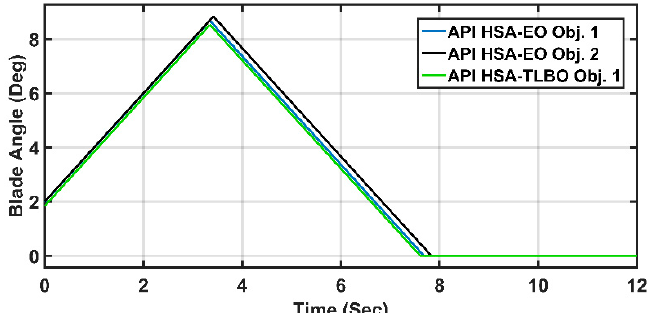
Figure 22. ( a ) Active power responses of normal fourth case. ( b ) Focusing active power responses of normal fourth case.